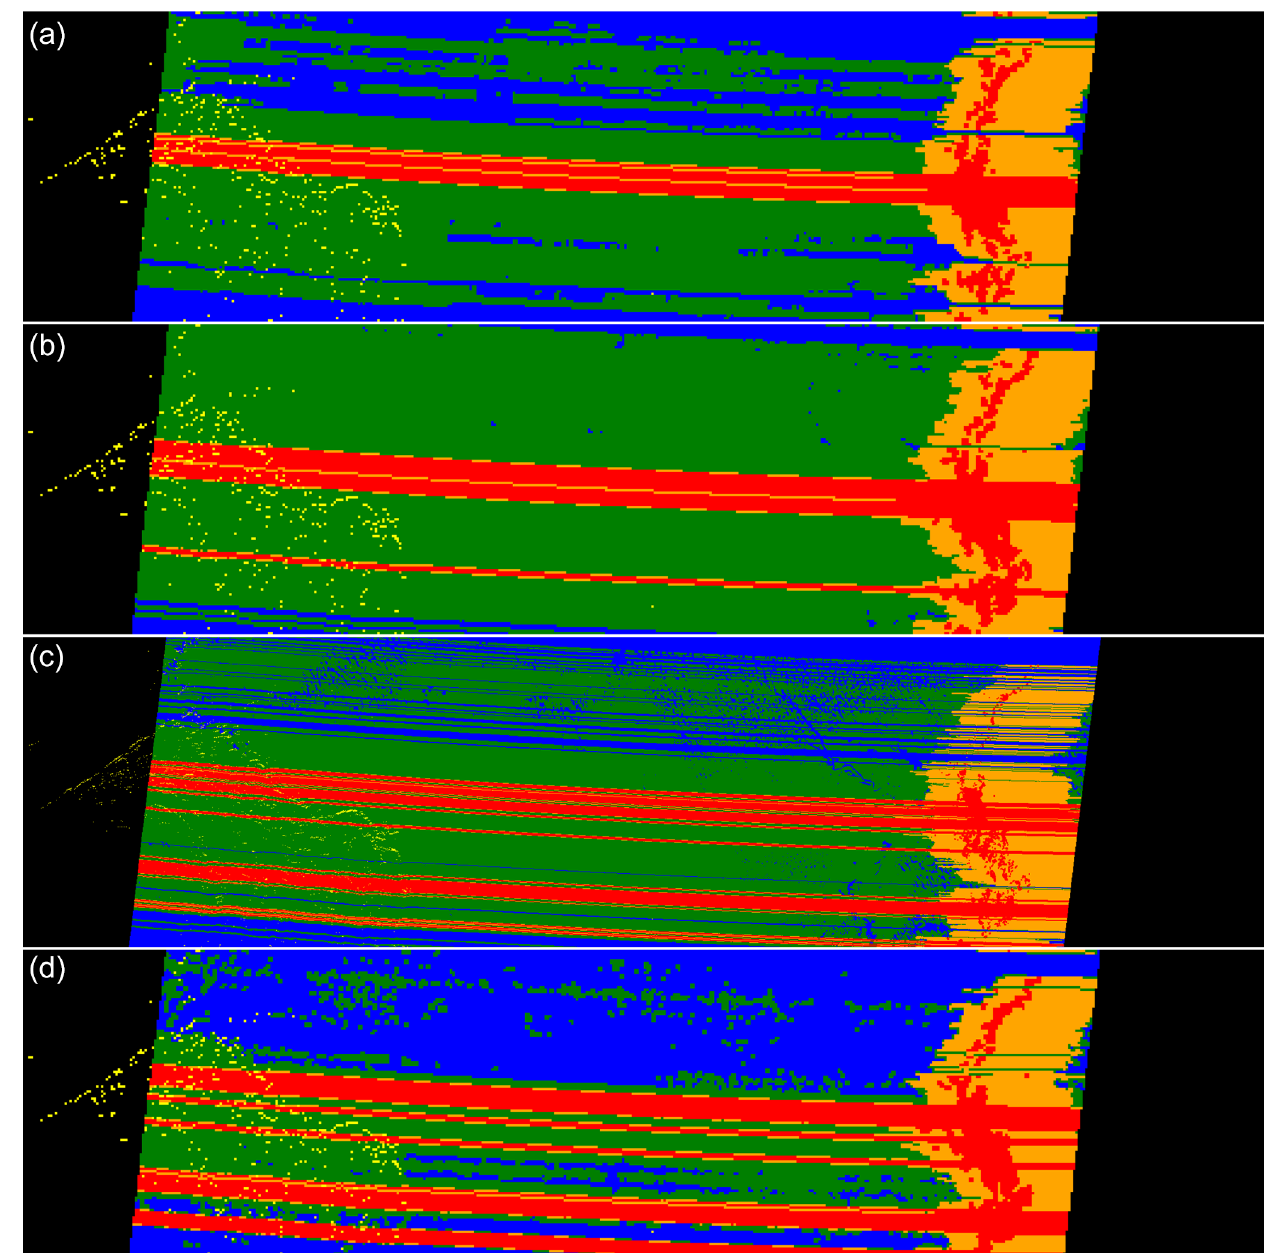
Figure 14. Maps of original RDQI values for GM, P168, O002111, B110 and camera BA in (from top to bottom) the blue, green, red and NIR spectral bands. The linear dimensions are the same as in Fig. 1, and color coding is as described in the legend of Fig. 10.